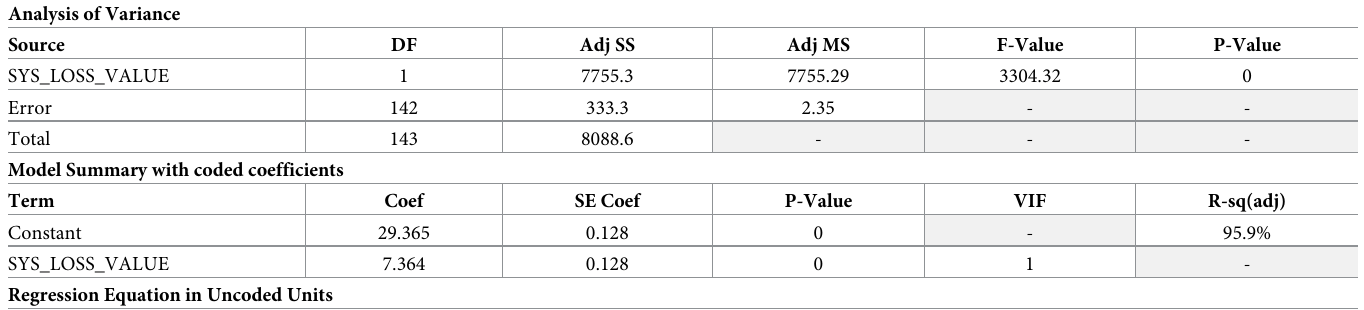
Table 3. Main cost: Straight trajectory.